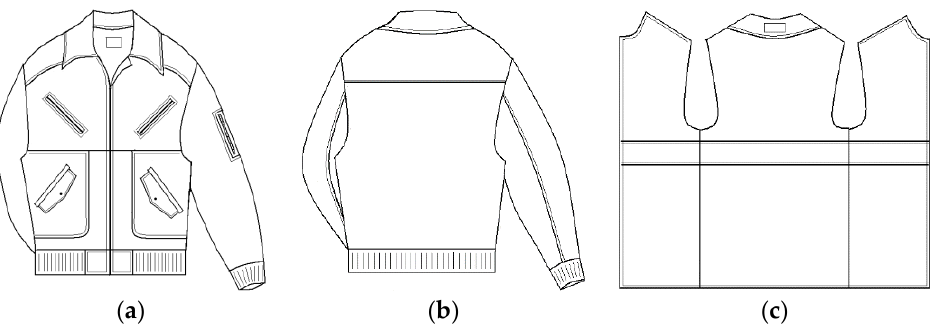
Figure 6. Sketch of the test jacket and thermal insert: ( a ) the front of the jacket; ( b ) the back of the jacket; ( c ) thermal insert. A fabric for the outer shell made of three-layer laminate designated as M3 (fabric upper-side: 100% polyester; membrane: polytetrafluoroethylene; fabric inner-side: 100% polyester fleece), a lining designated as M4 (100% polyester) and two types of thermal insulation material made of double-faced diamond-shaped quilted lining (DFDSQ lining) designated M5 (lining: 100% polyester; membrane: 100% polypropylene; padding: 100% polypropylene) and of fleece material designated M6 (100% polyester micro-fleece) were selected. The characteristic data for the fabrics used are given in Table 1, including material